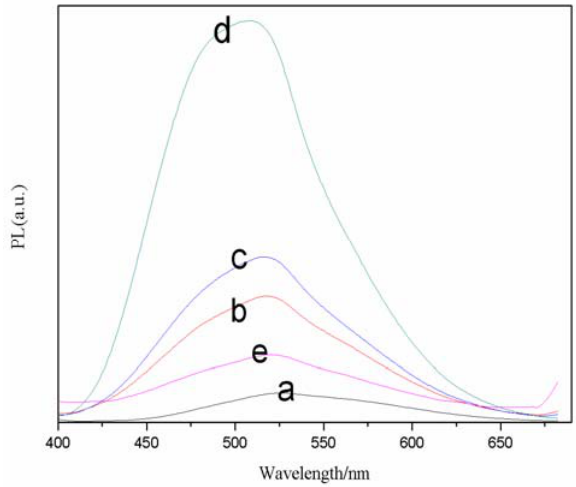
Figure 3. Effects of different molar ratios of Cd/Se on normalized FL spectra of TGA-capped CdSe QDs at freezing temperature. The reaction time was 30 min (a, 1.5; b, 2.5; c, 3.0; d, 3.5; e, 4.0).